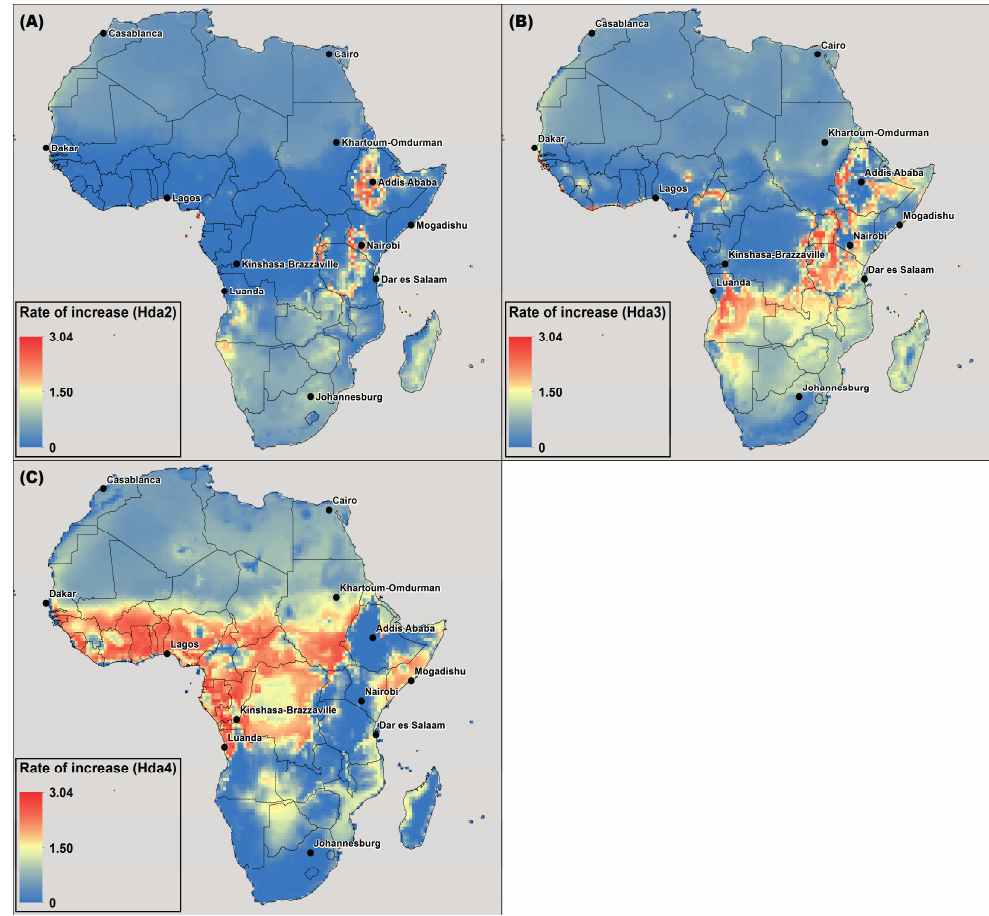
Figure 7. The average rate of increase of the 11-year moving average of ( A ) Hda2; ( B ) Hda3; ( C ) Hda4 for the median ensemble member for